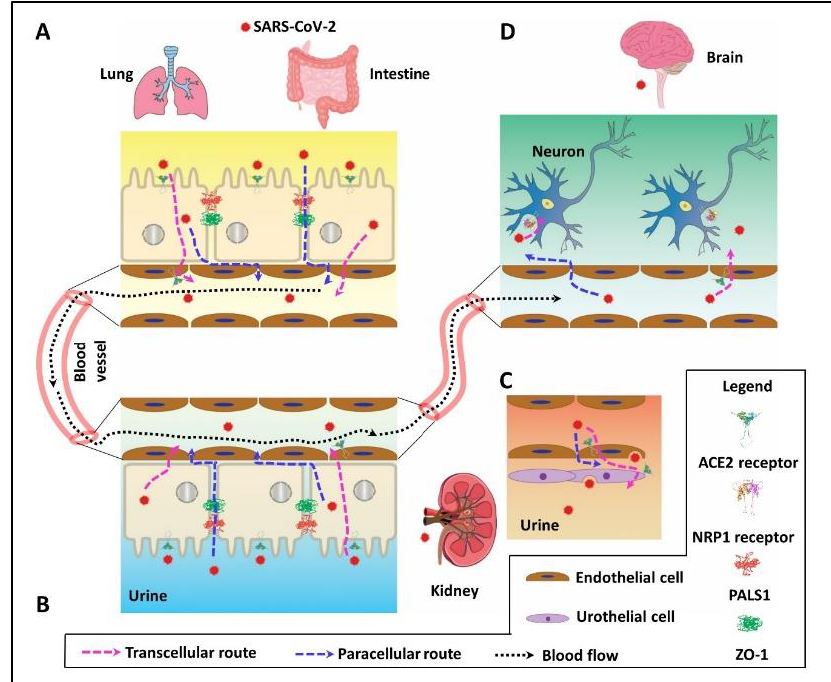
Figure 1. Invasive pathway of SARS-CoV-2 in the lung, intestine, kidney, and brain. ( A ) In the lung and intestine, SARS-CoV-2 may cross the epithelium barrier by ACE2 receptor-mediated endocytosis or paracellular leaky pathway. The virion can then enter the bloodstream by the paracellular leak